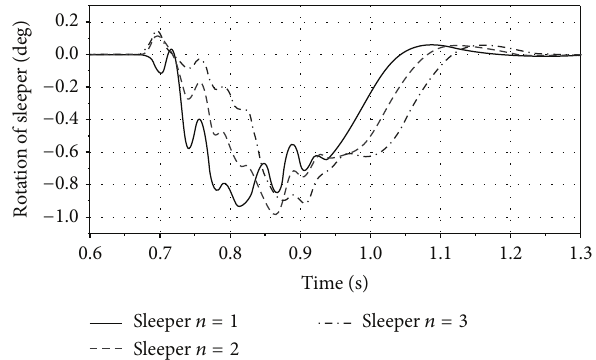
Figure 6: Rotation of three sleepers with double-point fastening during motion in the zone behind the bridge abutment.